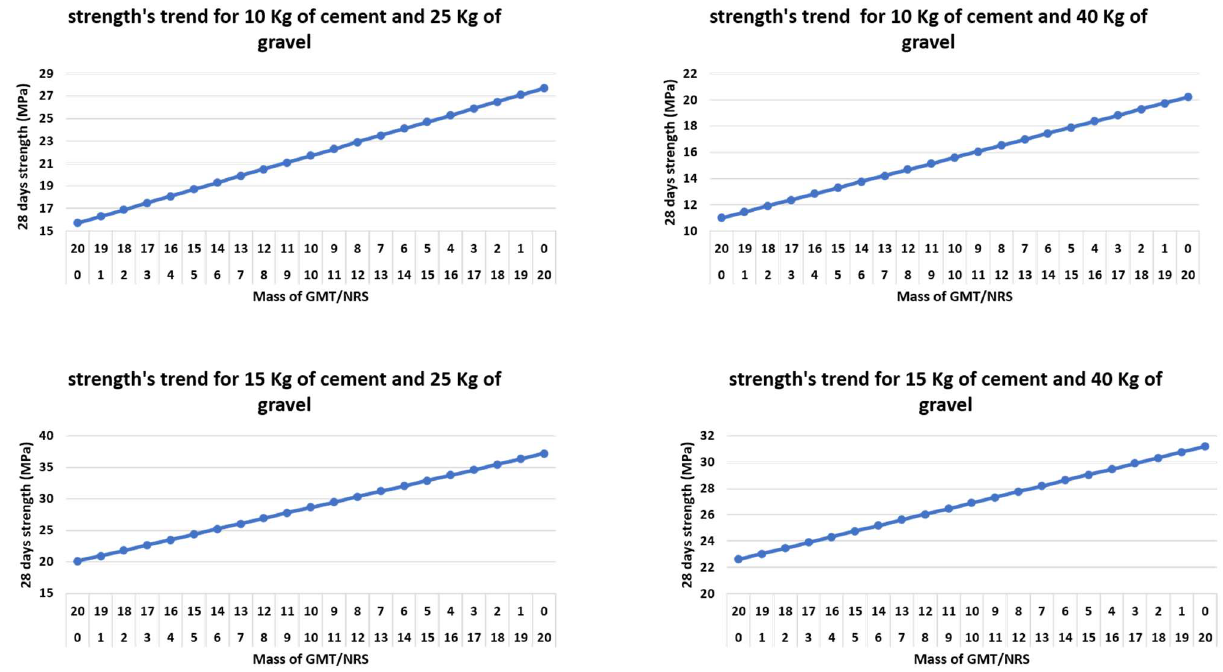
Figure 4. Influence of gravel in concrete on its compressive strength.